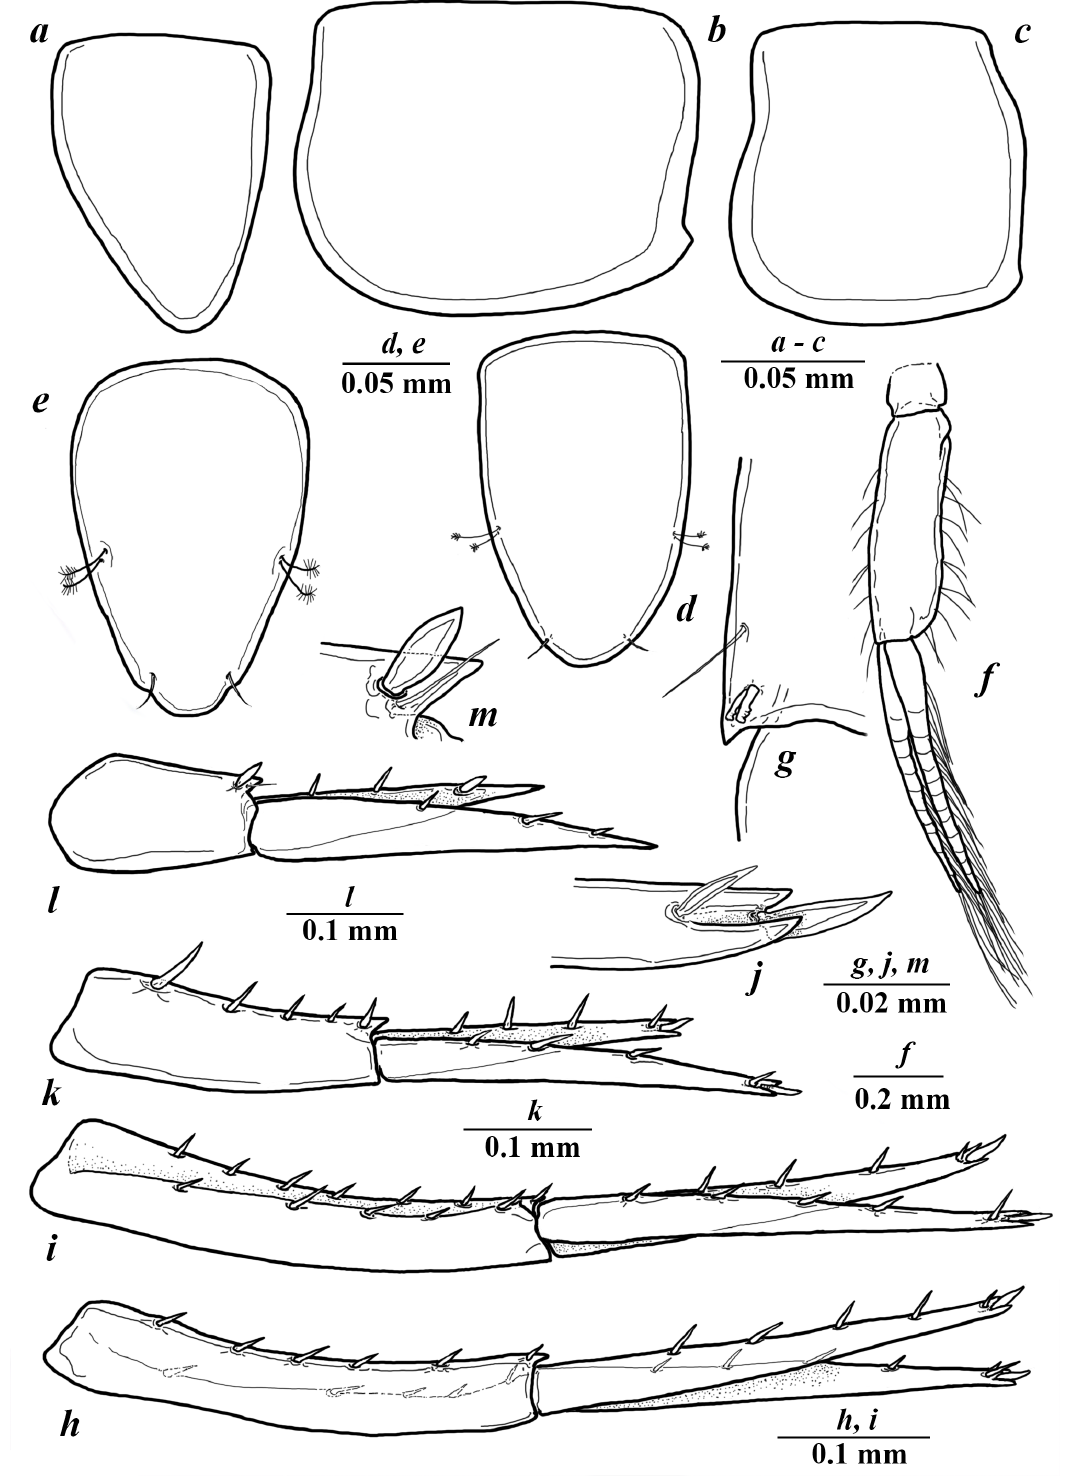
Fig. 5. Pleusymtes actiniae sp. nov. a–d, f–m . Paratype, ♀ (ZMMU Mb-1224). e . Paratype, ♂ (ZMMU Mb-1223). a . Epimeral plate I. b . Epimeral plate II. c . Epimeral plate III. d–e . Telson. f . Pleopod II. g . Retinacula of pleopod I. h–i . Uropod I. j . Same, distal part of outer ramus. k . Uropod II. l . Uropod III. m . Distodorsal angular spine of peduncle of uropod